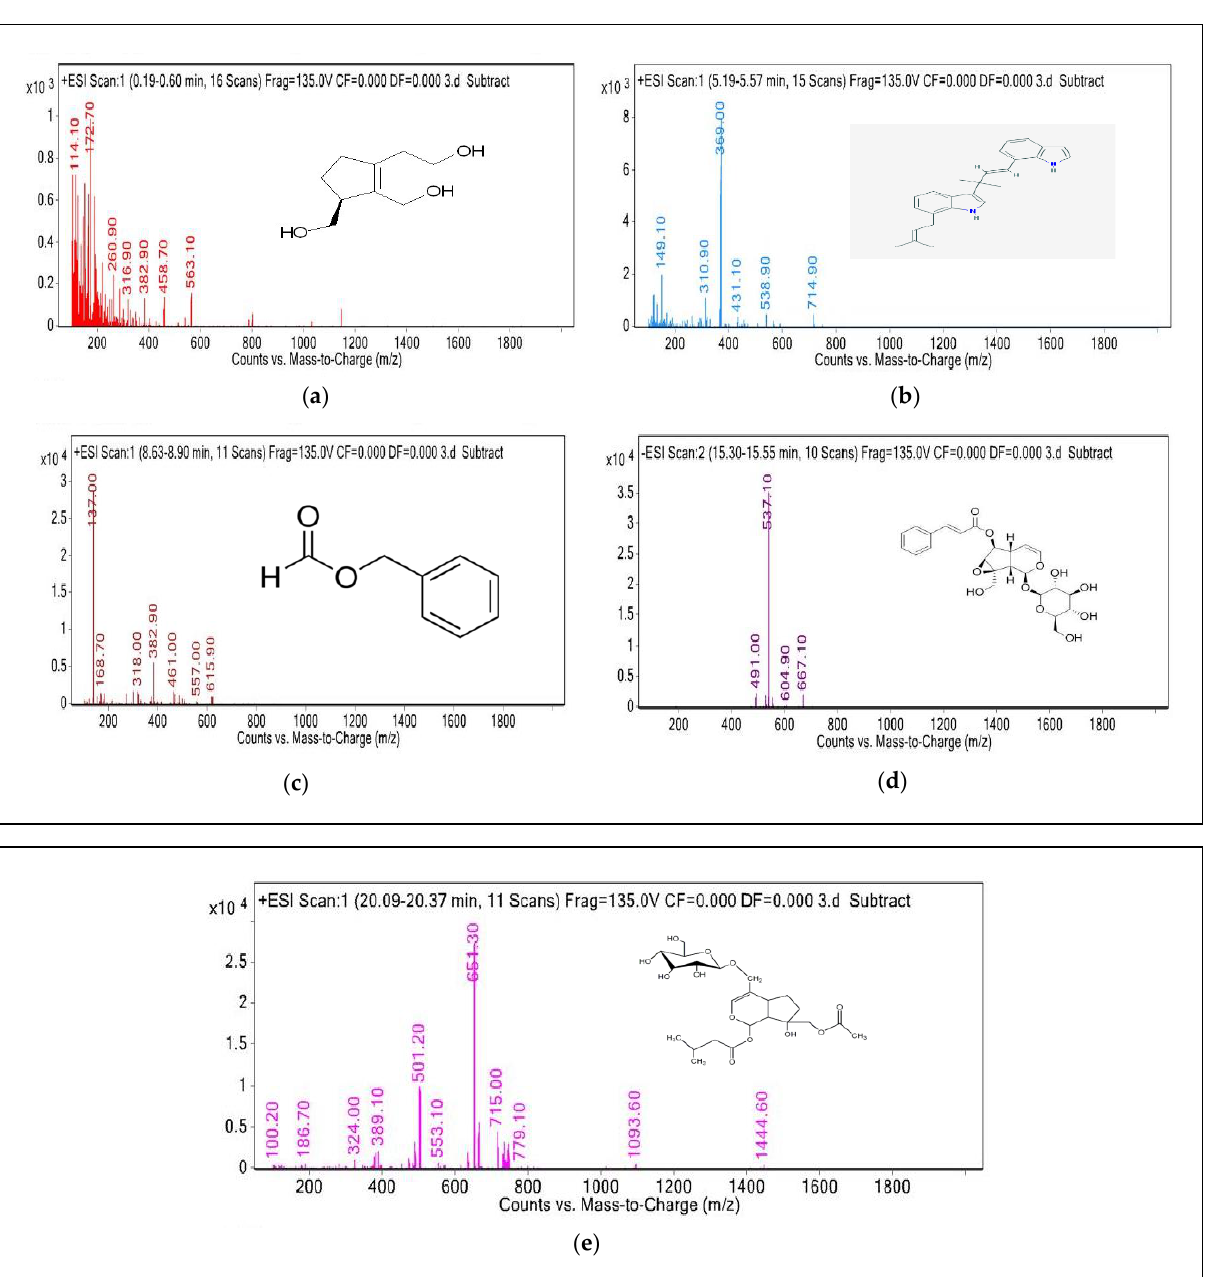
Figure 2. The compounds identified using LC – MS from the ethanolic extract of Picrorhiza kurroa : ( a ) cerberidol, ( b ) annonidine A, ( c ) benzyl formate, ( d ) picroside 1, ( e ) furcatoside